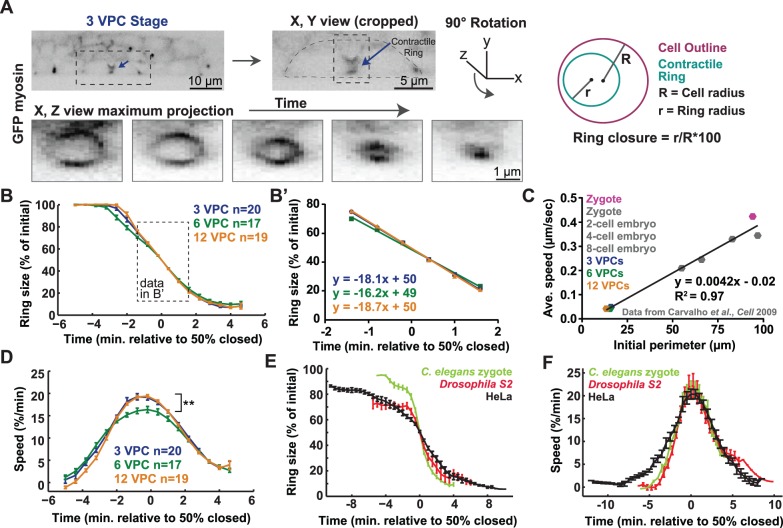
Quantitative analysis of the kinetics of contractile ring closure in the VPCs.(A) Maximum intensity projection images of a worm expressing myosin::GFP at the 3 VPC stage. Left: dotted box: dividing cell; arrow: contractile ring. Scale bar = 10 µm. Middle: enlargement of the dividing cell (dotted outline); dotted box and arrow: contractile ring. Scale bar = 5 µm. The cropped contractile ring is rotated 90° to generate a z, x maximum projection. Bottom: contractile ring closure over time. Scale bar = 1 µm. Right: representation of ring annotation and the parameters quantified: red = cell outline; green = contractile ring; R = cell radius; r = ring radius; Ring closure = r/R*100. (B) Average percentage of contractile ring closure over time aligned at the midpoint of closure for the first (purple), second (green) and third (orange) rounds of VPC cytokinesis. Purple/first: n(cells) = 20, n(worms) = 11. Green/second: n(cells) = 17, n(worms) = 6. Orange/third: n(cells) = 19, n(worms) = 8. Error bars = SEM. Dotted box: data for B’. (B’) Linear regression lines and their equations for 20%–80% ring closure (data from B). (C) Furrowing speed versus division plane perimeter (3 VPC: purple, 6 VPC: green and 12 VPC: orange, grey: data from [17]; pink: our zygote measurement). Linear regression fitted to all 8 data points. (D) Average speed of contractile ring closure over time for the three rounds of VPC cytokinesis. First round/purple, n(cells) = 20, n(worms) = 11, second/green, n(cells) = 17, n(worms) = 6, third/orange, n(cells) = 19, n(worms) = 8. **: p = 0.006 for 6 versus 12 VPC stage at time 0, unpaired t-test. Error bars = SEM. (E–F) Graphs of average percentage of ring closure and speed over time for HeLa cells (black), Drosophila S2 cells (red) and the C. elegans zygote (light green). C. elegans zygote: n(cells) = 9, Drosophila S2: n(cells) = 5, HeLa: n(cells) = 8. Error bars = SEM.